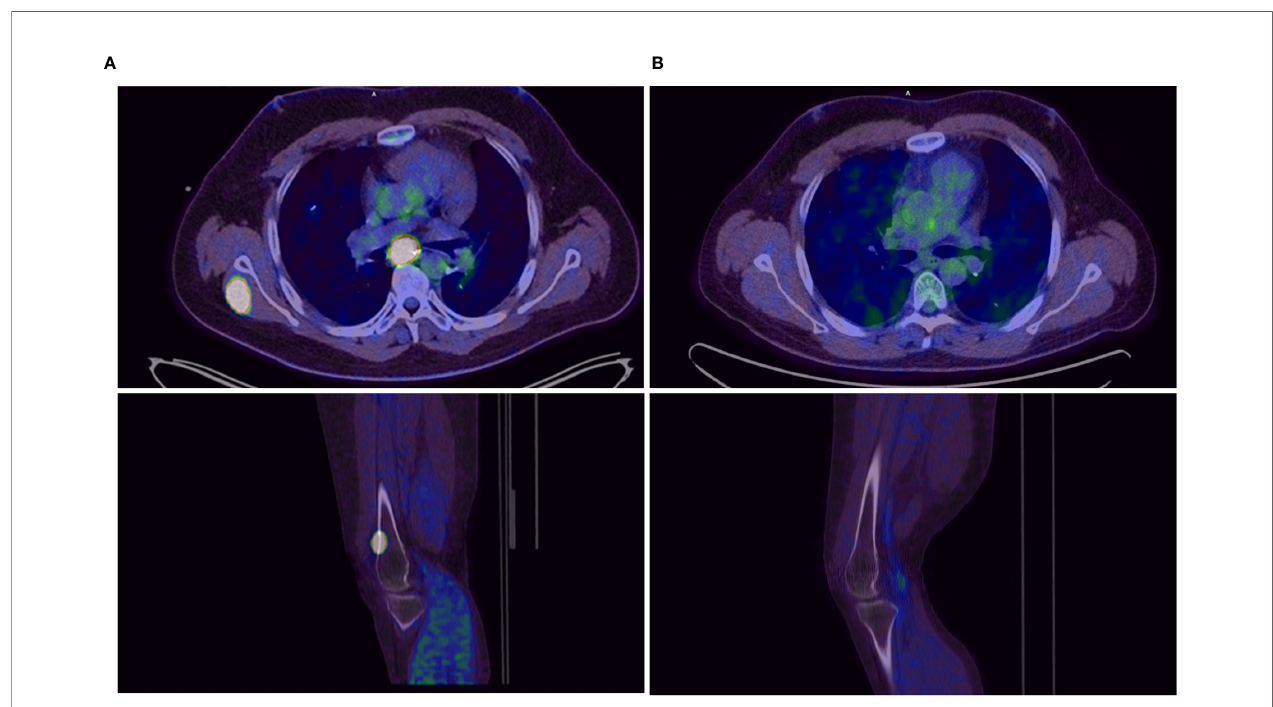
FIGURE 3 | Tumor lesions before (A) and after 3 months (B) of double checkpoint inhibition with ipilimumab and